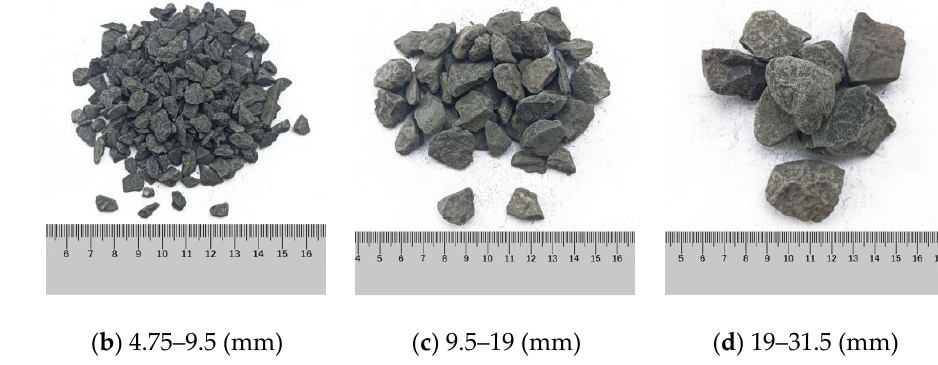
Figure 3. Sampling of coal gangue.